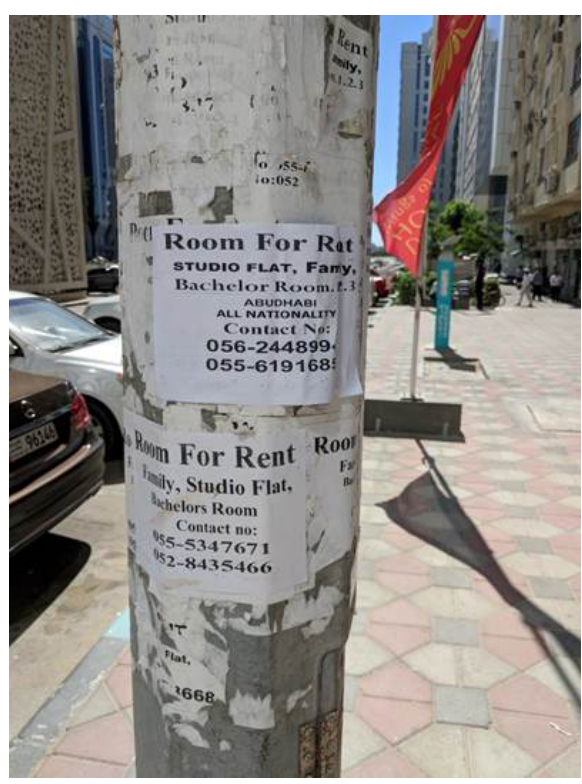
Figure 2 Informal housing arrangements. Workers appear socialising in the study area in the distance, whereas areas further away from the building are usually empty and lifeless (Source: